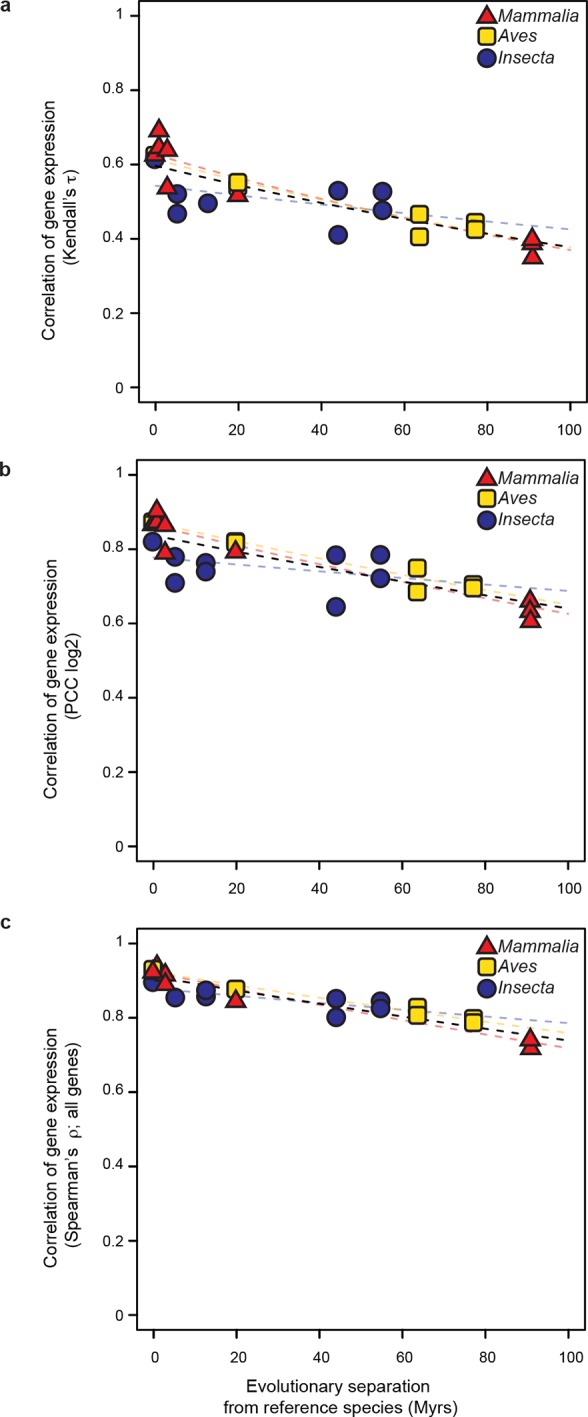
The common evolutionary rate of gene expression levels presented in Figure 3 is robust to changes in correlation metrics or expression threshold.(a, b) The gene expression levels used in Figure 3 were correlated with alternative correlation metrics, Kendalls τ (a) and Pearson’s r (b). The resulting evolutionary rates remained statistically indistinguishable. (c) The gene expression level of all genes were analyzed rather than excluding the values below 5 TPM as was done in Figure 3. The resulting evolutionary rates remained statistically indistinguishable.